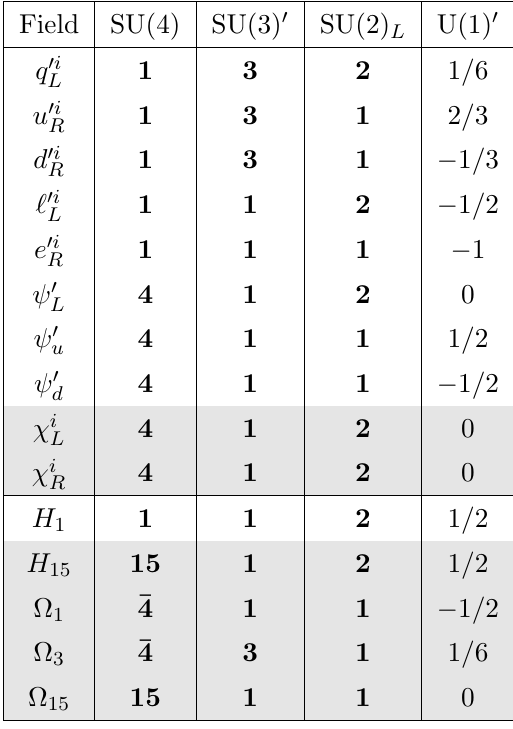
Table 2 . Field content of the model ( i = 1 ; 2). Particles added to the SM matter content are shown on a grey